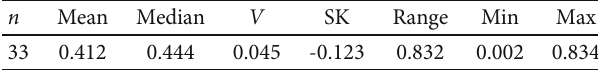
Table 7: MLEs and MSE of DWQL distribution for set 1 and set 2 : n Set 1 (0.5, 0.5)